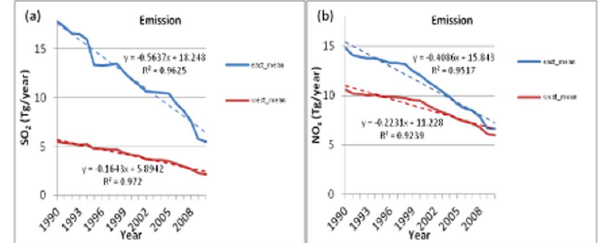
Fig. 4. Scatter plot for AOD vs. anomaly PM 2 . 5 . Left panel is for eastern US and right panel is for western US. The best-fit equa- tion and coefficient of determination ( R 2 ) are given at right in each